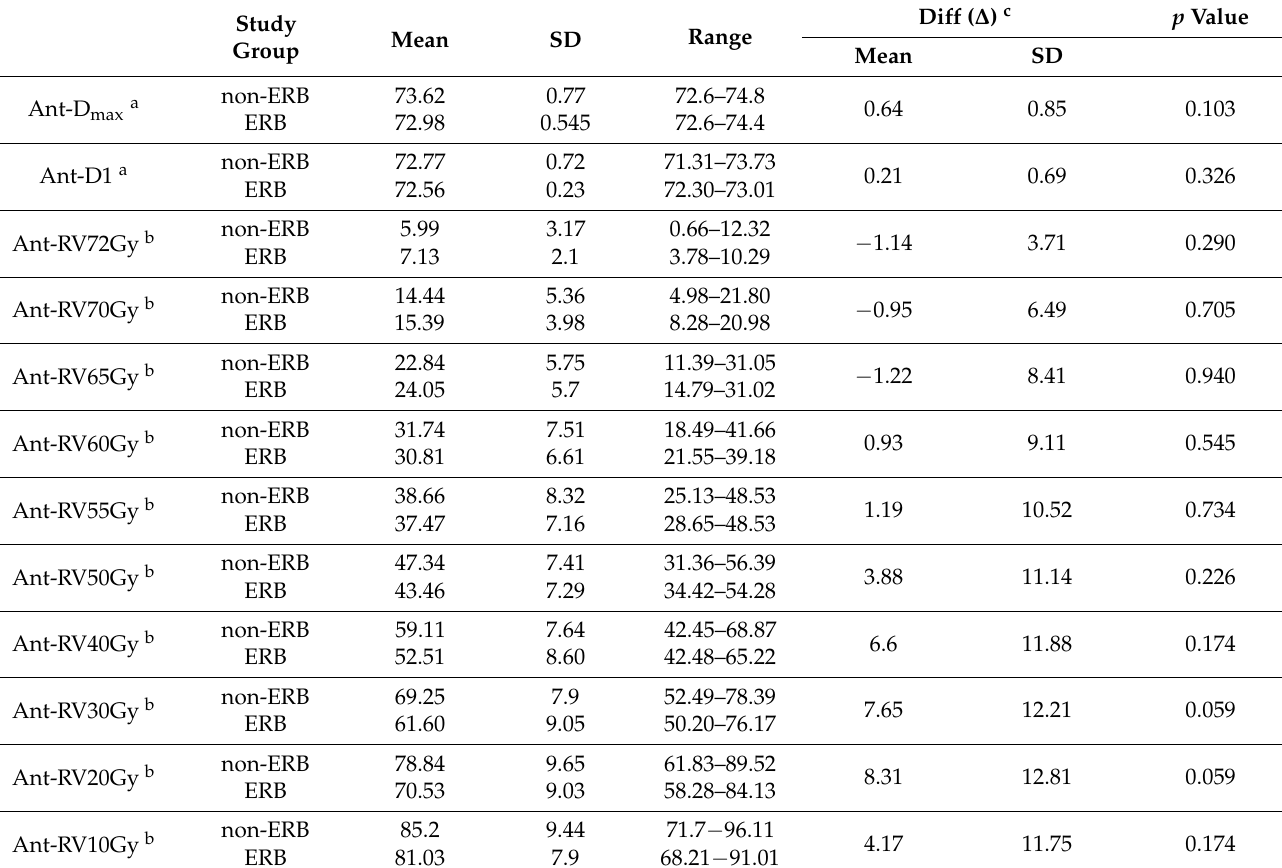
Table 2. DVH analysis for the anterior rectum comparing between the non-ERB plans and ERB plans:.